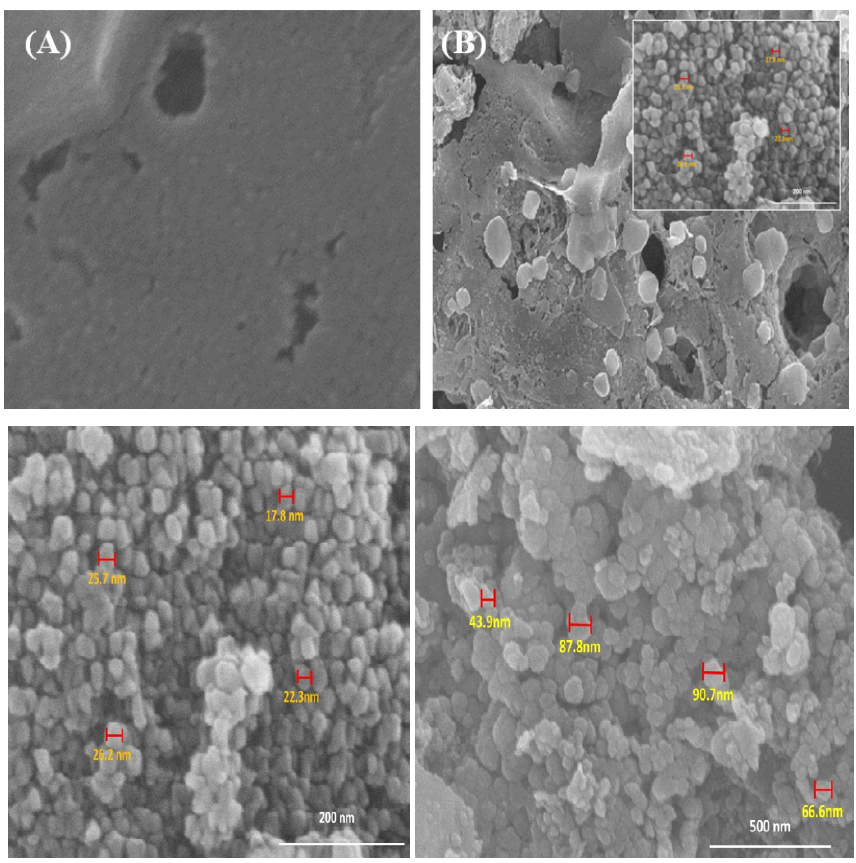
Fig.4. (A) Before treatment, (B) After